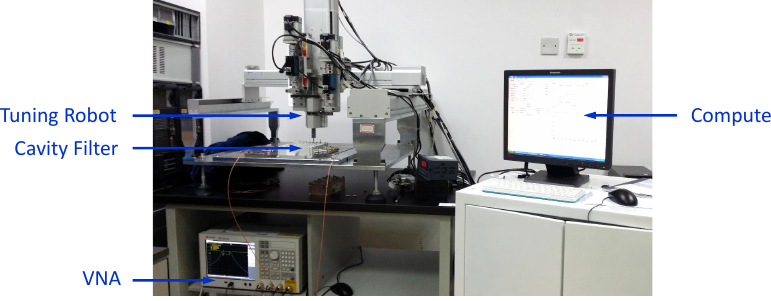
Figure 6. The automatic tuning robot system used for experiment.